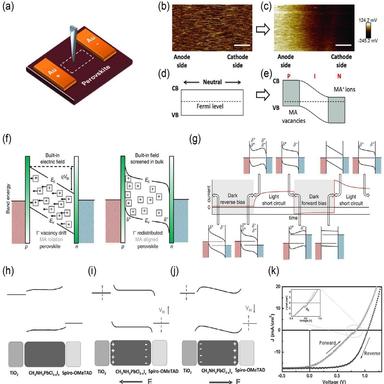
(a) Schematic of the KPFM measurements of the lateral structure devices. KPFM potential images (b and c) and corresponding energy diagram (d and e) of MAPbI3 films between the two Au electrodes before (b and d) and after (c and e) electrical poling, respectively. The scale bar is 6 mm. Copyright 2015, Wiley-VCH GmbH. (f) Schematic diagrams of vacancy drift and band bending in a p-i-n device at short circuit. (g) Hypothesized energy level configurations corresponding to different bias condition